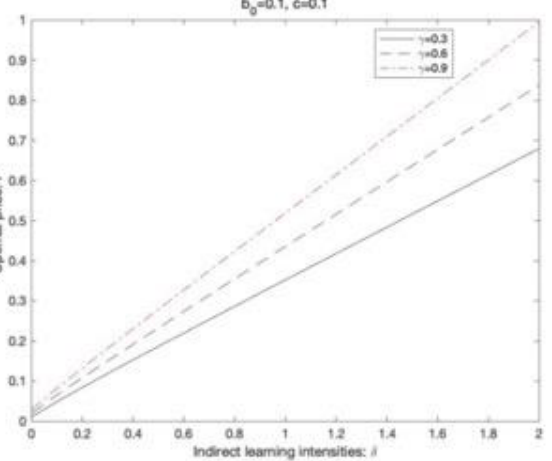
Figure 5. The impact of indirect learning intensity 𝛿 on pricing strategies.